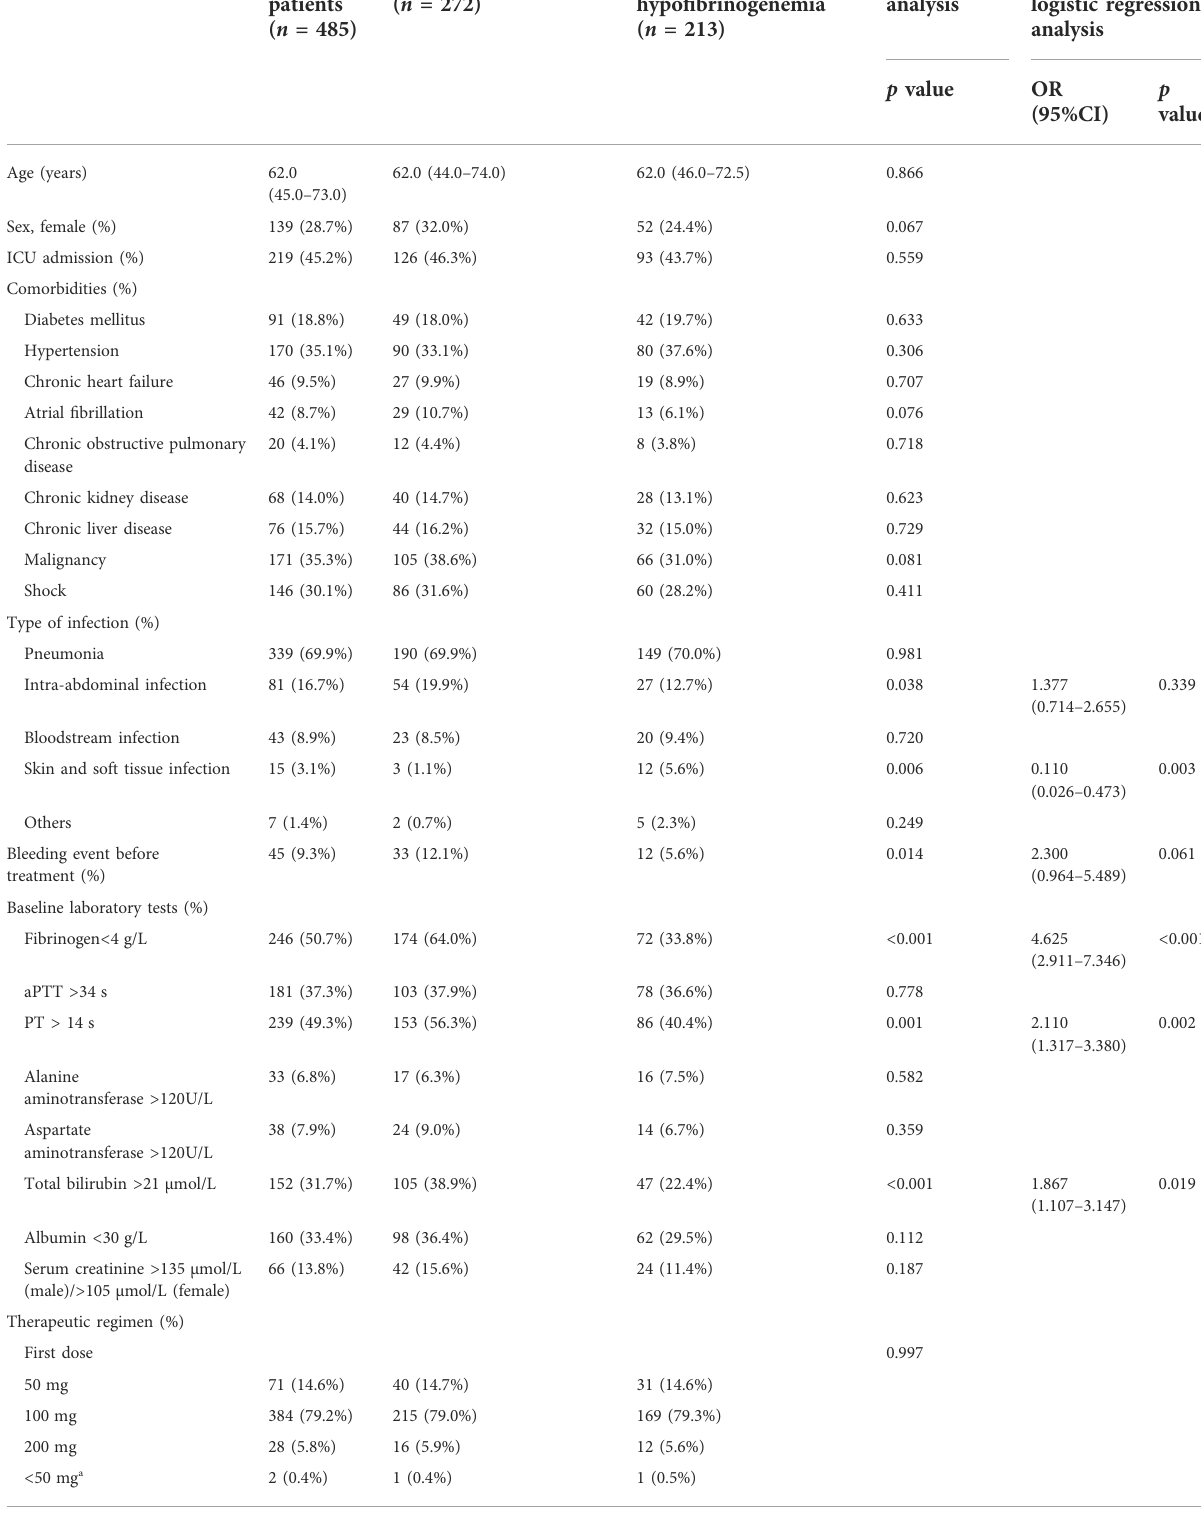
TABLE 4 Comparison of demographic and clinical characteristics of patients with hypo fi brinogenemia and non-hypo fi brinogenemia during tigecycline